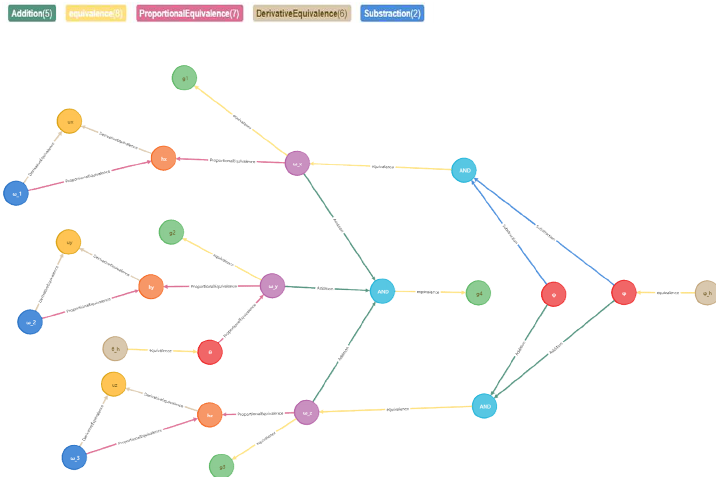
Figure 4. Performance-fault relationship graph of spacecraft control system.